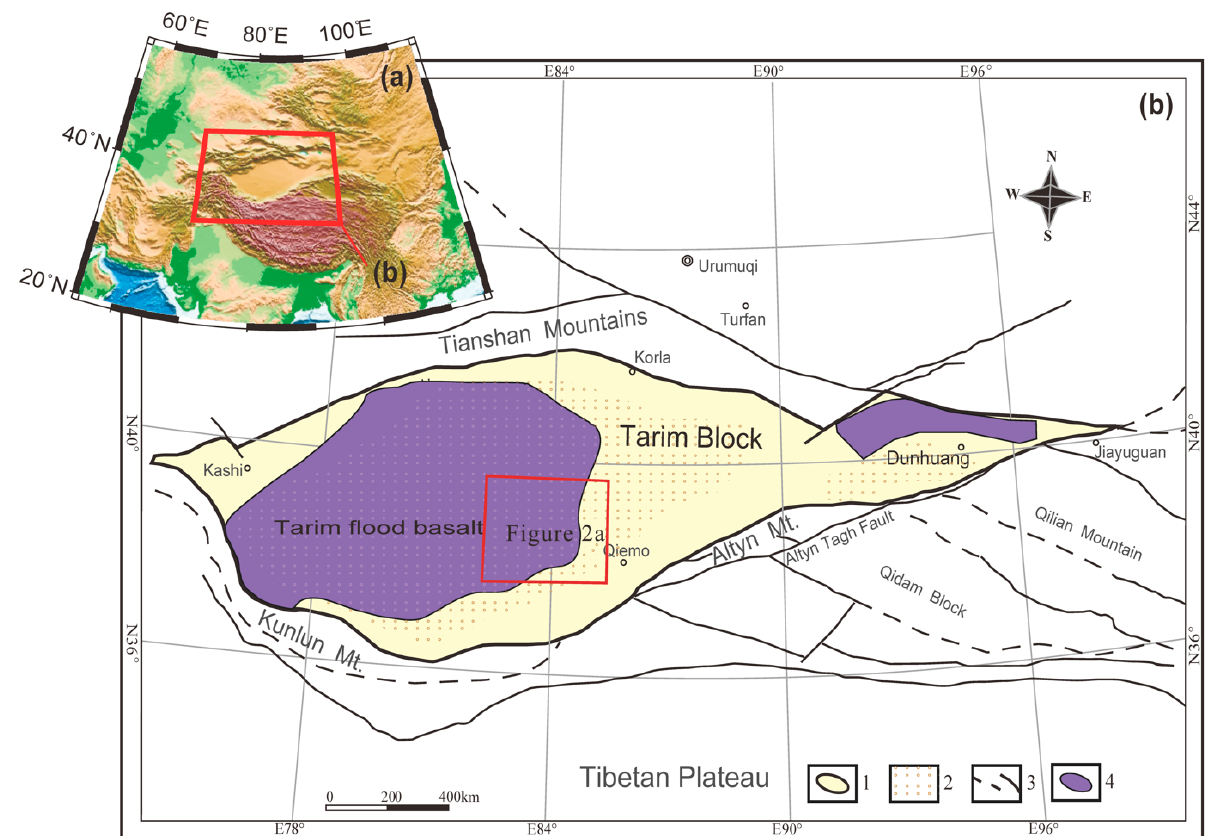
Figure 1. Sketch geological map showing the spatial distribution of the early Permian Tarim flood basalt. Inset map ( a ) shows a broader view of the Tibetan–Tarim–Tianshan domains. Study area is shown as a rectangle in the regional geological map of Tarim basin ( b ). Legend in ( b ): 1, the Tarim Block; 2, desert; 3, major faults; 4, estimated distribution of the Tarim flood basalt.